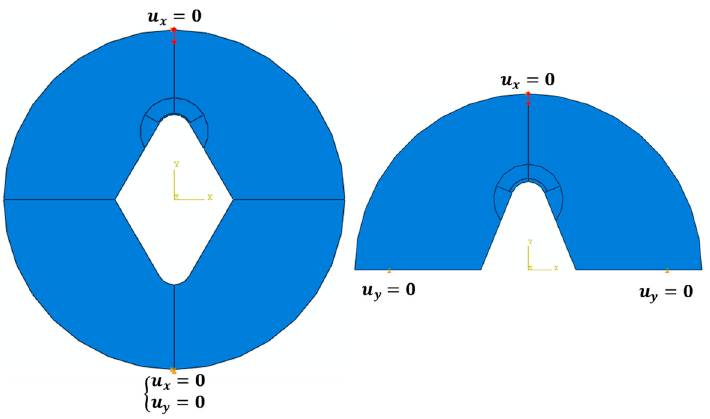
Figure A1. The boundary conditions and partitioning for RVNBD and RVNSCB samples.